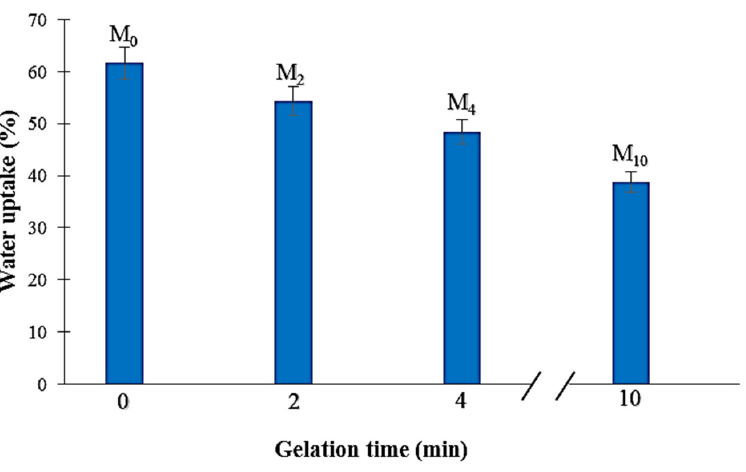
Figure 8. Water uptake of the obtained PA6 membranes as a function of the gelation time.